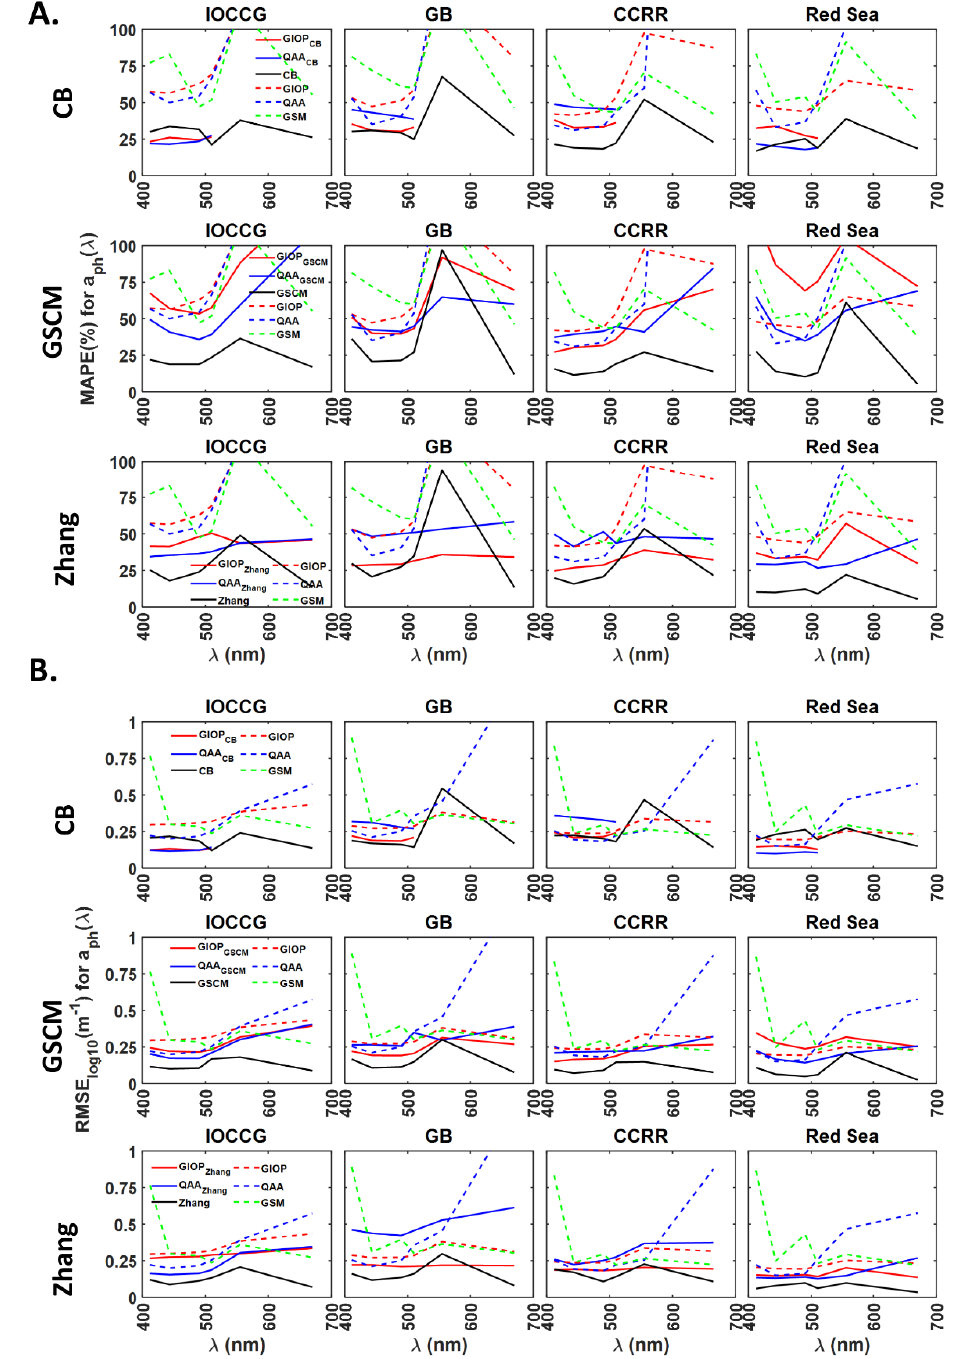
Figure 6. Comparison of GIOP CB , QAA CB , GIOP GSCM , QAA GSCM , GIOP Zhang and QAA Zhang models in deriving a ph ( λ ) from R rs ( λ ) of IOCCG, GB, CCRR and Red Sea datasets using ( A ). MAPE and ( B ). RMSE in log scale. Here, GIOP CB indicates that GIOP algorithm with default configuration is used to derive a nw ( λ ) from R rs ( λ ) of each of the four datasets. In the second step, the GIOP-derived a nw ( λ ) is used as input to CB algorithm to obtain absorption subcomponents of a ph ( λ ) and a dg ( λ ) . The same procedure is used in GIOP Zhang , QAA Zhang , GIOP GSCM and QAA GSCM models. GIOP, QAA and GSM are the existing operational semi-analytical algorithms that use R rs ( λ ) as input and provide absorption subcomponents as outputs. The CB, GSCM and Zhang’s models use spectral non-water absorption coefficient, a nw (λ) as input to derive the absorption subcomponents.